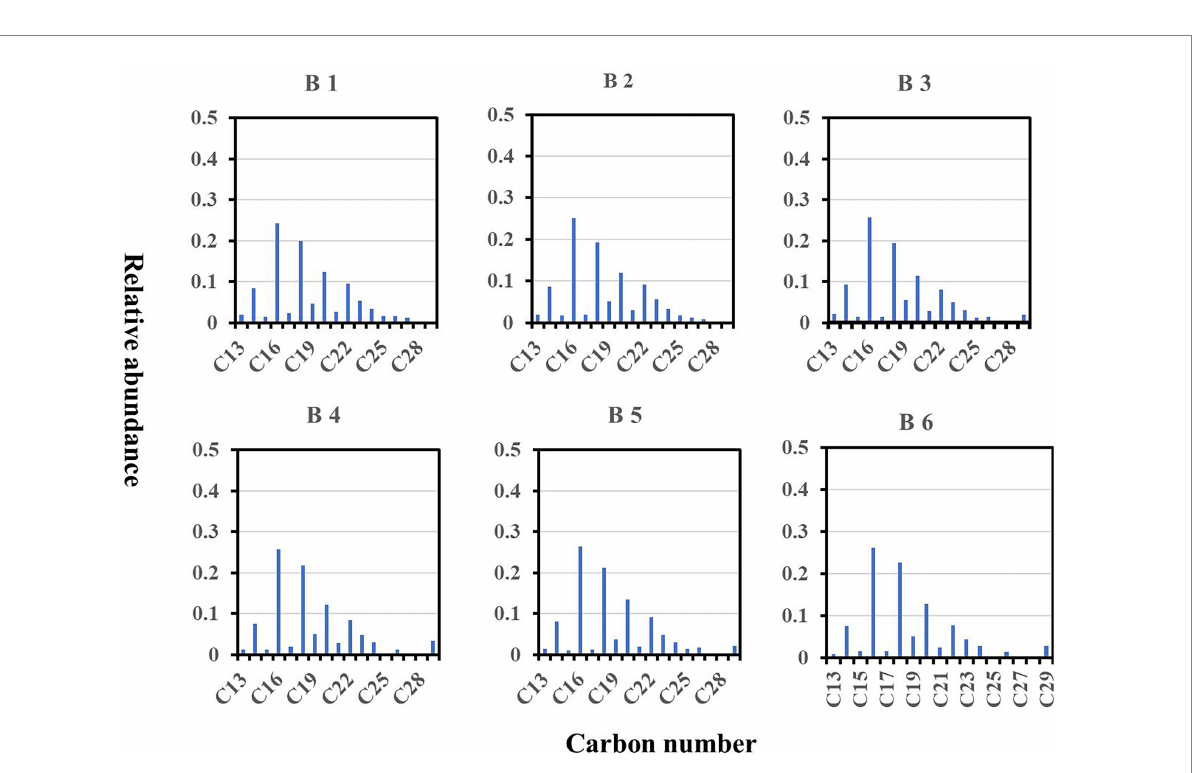
FIGURE 3 Concentration distributions of n-alkanes among